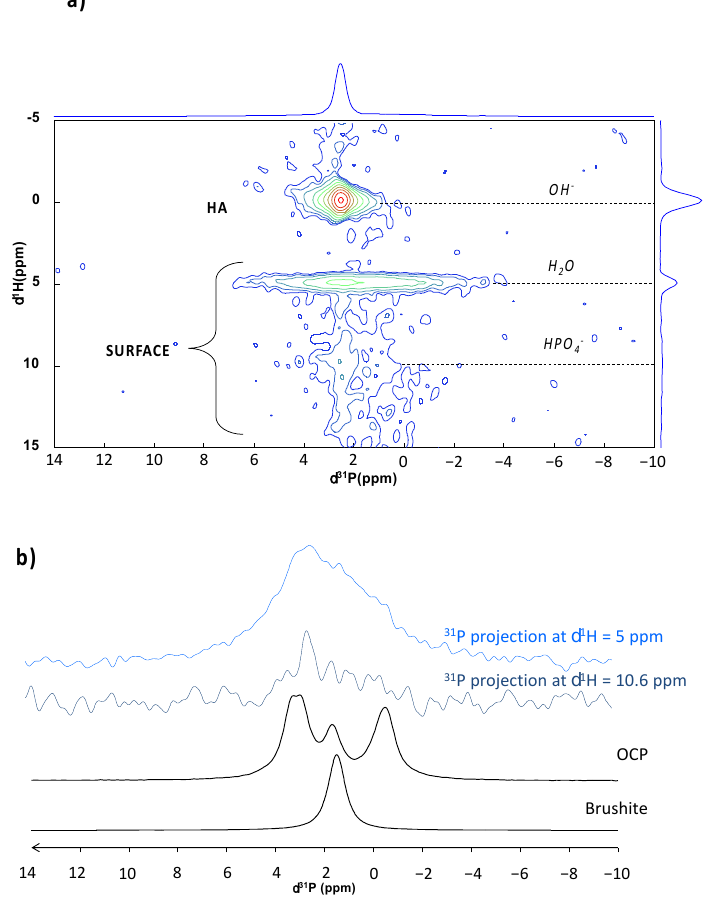
Figure 6. ( a ) 1 H- 31 P 2D HETCOR NMR spectrum of CO 2 treated BCP scaffold. ( b ) Comparison of 31P signal from surface species (projections from the 2D HETCOR spectrum) with 31 P NMR spectrum of reference CaP samples.